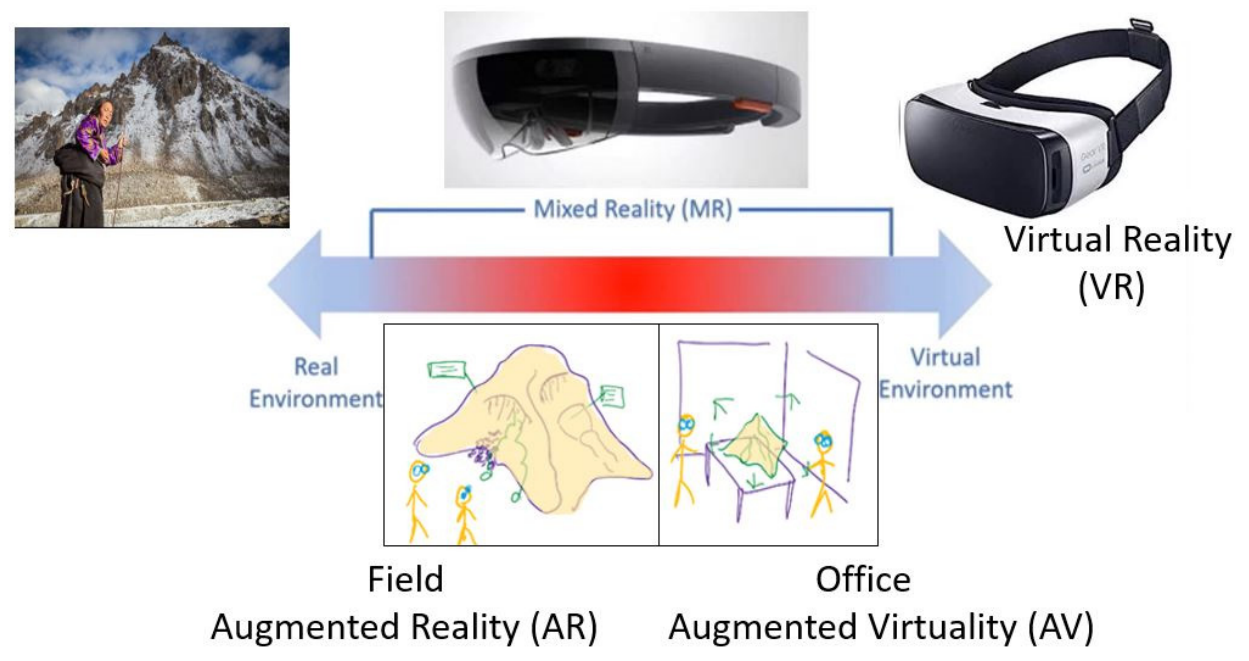
Figure 2. The reality–virtuality continuum [19,20] (adapted from [15,23]).